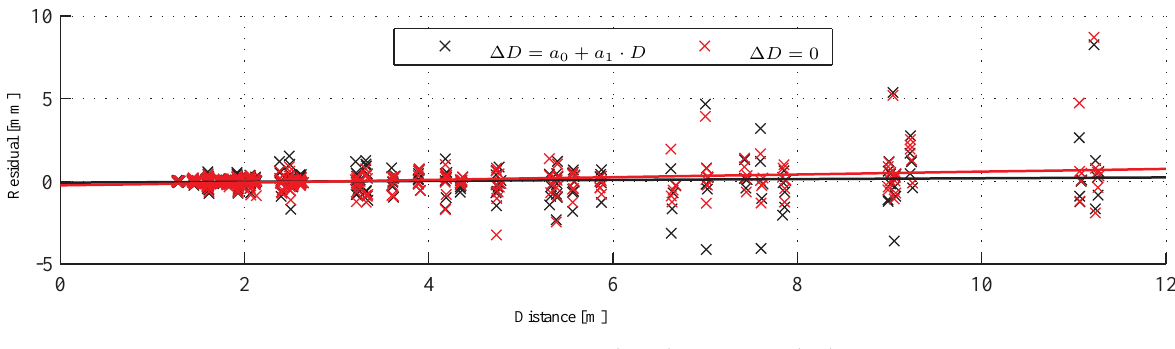
Figure 7: Residuals of the distance measurements with (black) and without (red) correction